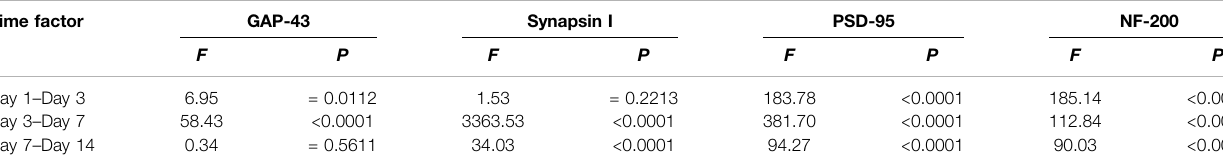
TABLE 6 | Simple effects of prolonged treatment time on ANOVA of neurocritical